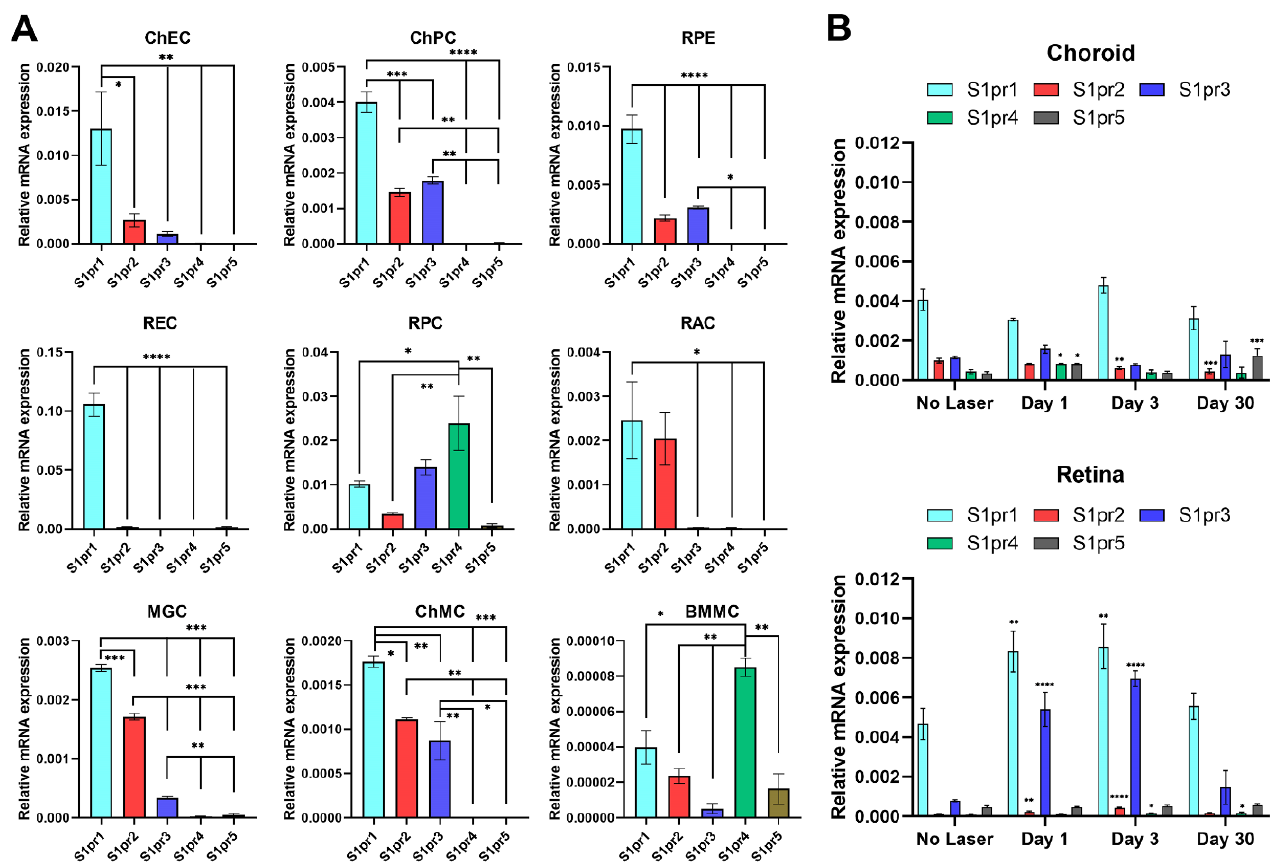
Figure 1. Expression of S1PR in various ocular cells. ( A ) Total RNA was extracted from murine ChEC, ChPC, RPE, REC, RPC, RAC, MGC, ChMC, and BMMC or ( B ) retina and choroid/RPE tissue, as outlined in Methods. A total of 1 µg of total RNA was used for cDNA synthesis. cDNA was used as the template for qPCR performed in triplicates of three biological replicates using specific gene primers (Table 1). The RpL13A was used as a control. The relative amounts of transcripts were determined, as detailed in Methods. * p < 0.05; ** p < 0.01, *** p < 0.001, **** p < 0.0001. ( n =